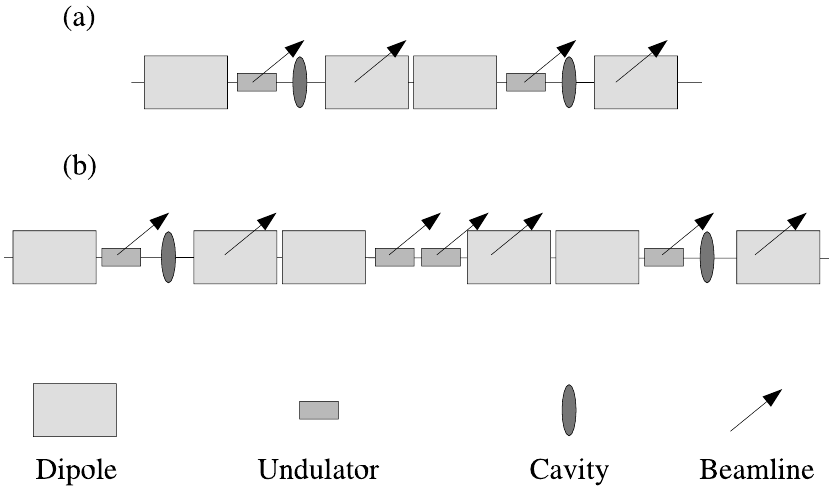
FIG. 1. Arrangement of components requiring minimal changes to the APS optics (after Sajaev [24]). In the first arrangement (a) chirped pulses are provided to a single undulator beam line and a single bending magnet beam line. In the second arrangement (b) chirped pulses are provided to three undulator beam lines (assuming canting of the middle pair [12]) and two bending magnet beam lines. The many quadrupoles and sextupoles that exist in the lattice are omitted from this drawing, for